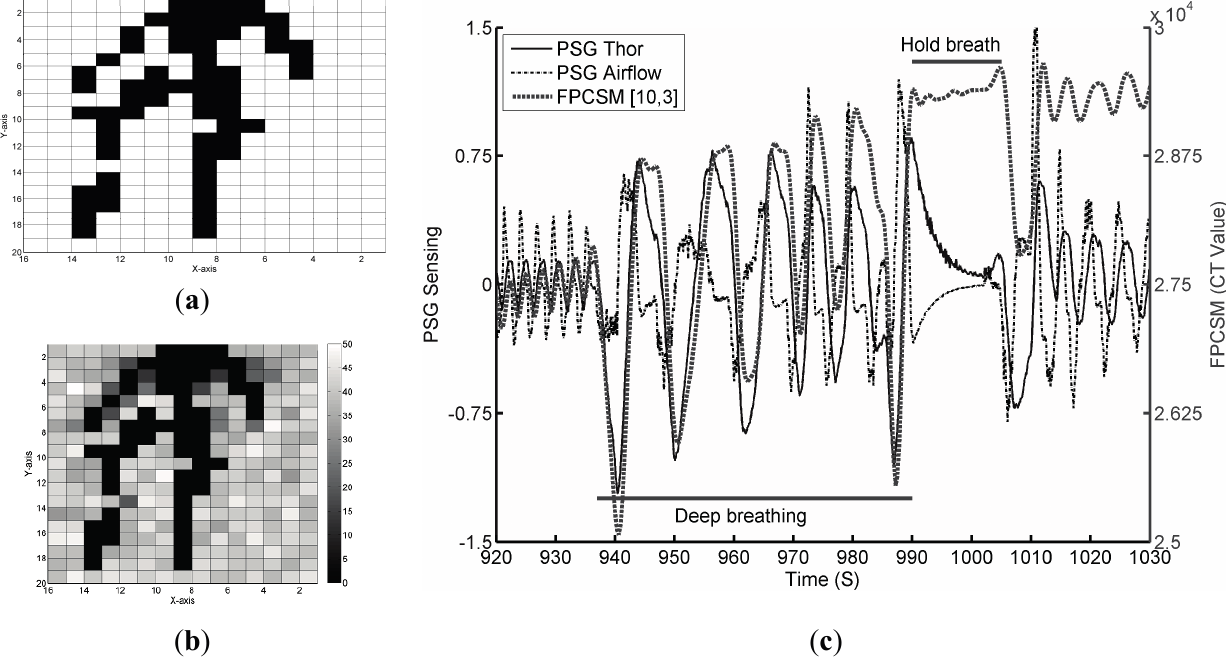
Figure 8. Results for subject lying on his back performing test respiration patterns (deep breathing and breath hold): ( a ) electrodes with true values; ( b ) the N TSC values of the electrodes; and ( c ) the PSG and FPCSM respiration waveforms for the test respiration